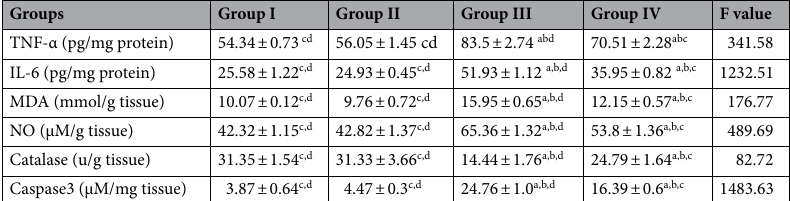
Table 2. Effect of FUC on oxidant/antioxidant biomarkers, apoptosis and inflammatory biomarkers among the studied groups. Data are represented as mean ± SD. Statistical analysis was carried out using one-way ANOVA with Tukey’s post hoc test, SPSS computer program. a–d Significant difference between groups at * p < 0.05. a Significance from group I; b significance from group II; c significance from group III; d significance from group IV. Degree of freedom is (3) between groups and (24) within groups (total = 27). TNF-α Tumor necrosis factor-alpha, IL-6 Interleukin-6, MDA MDA, NO Nitric oxide.